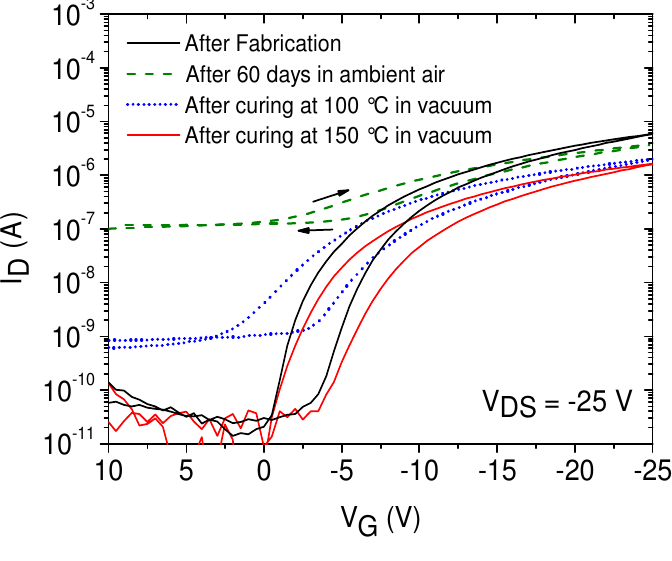
Figure 12. Transfer curves of organic transistors based on automated dispensing of FS111 on SU-8 dielectrics on PEN foil directly after fabrication and after 60 days using different curing temperatures.